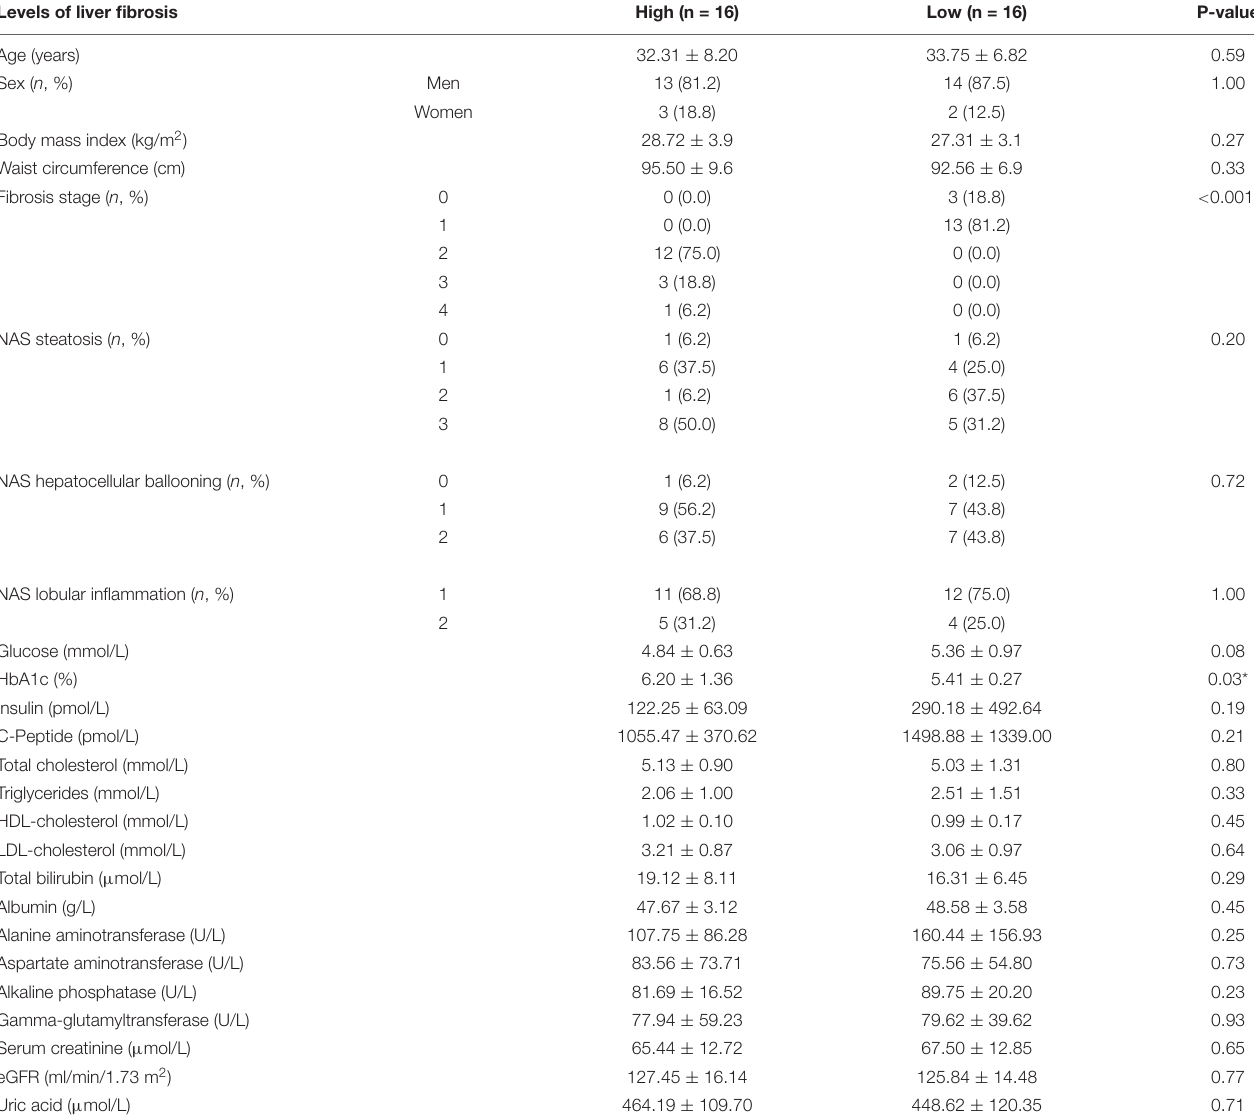
TABLE 1 | Main clinical and biochemical characteristics of patients with biopsy-proven NAFLD stratified by high or low levels of liver fibrosis. Levels of liver